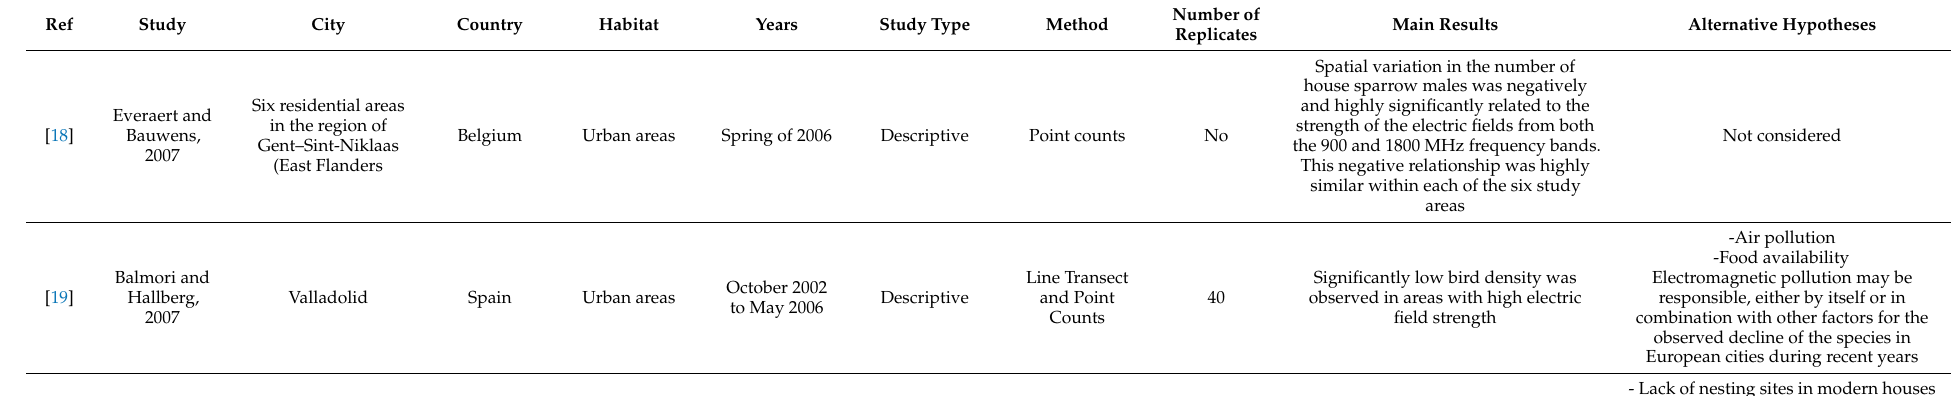
Table 1. House sparrows vs. radiation